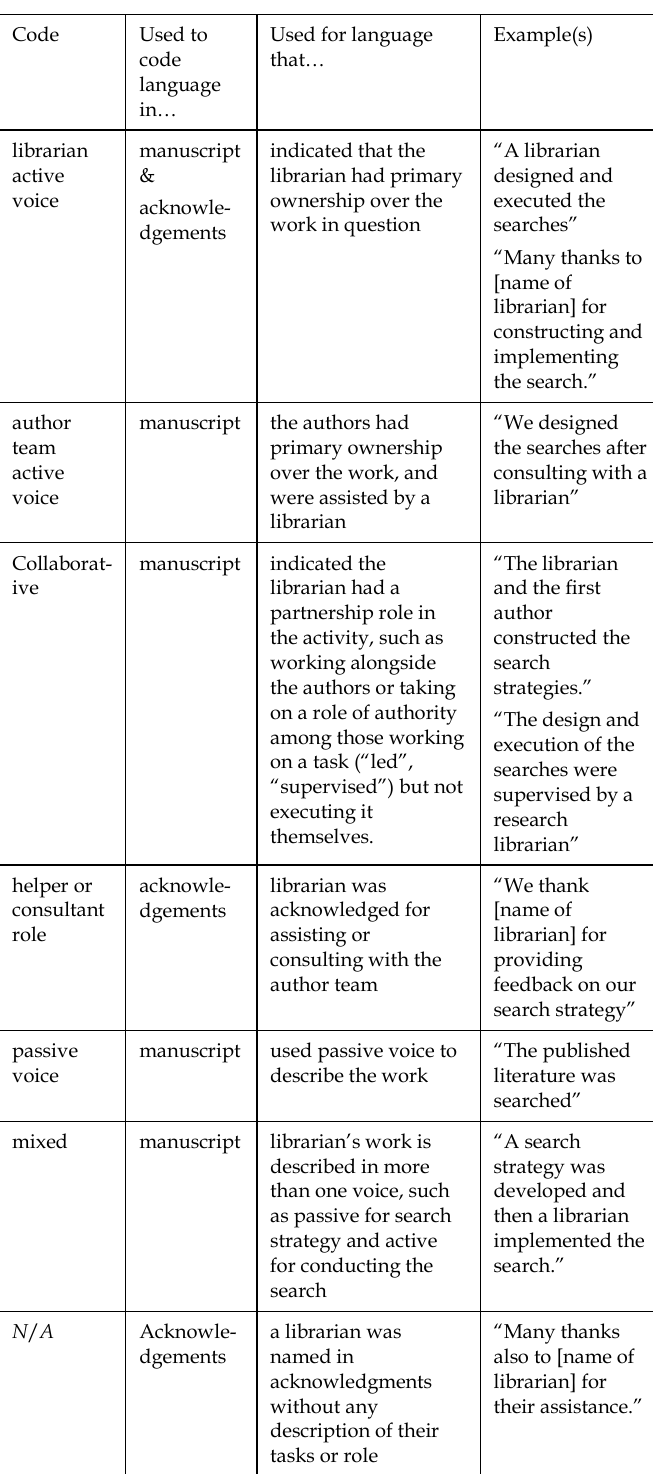
Table 1 Codes for language about librarian’s